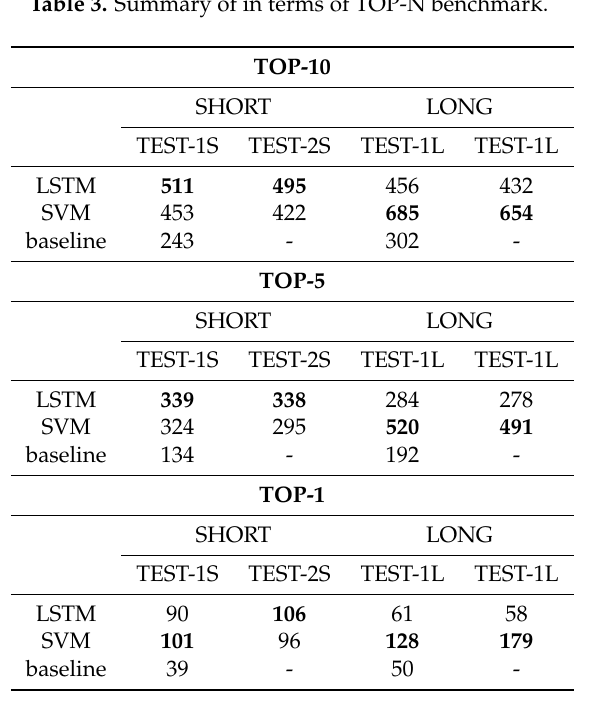
Table 3. Summary of in terms of TOP-N